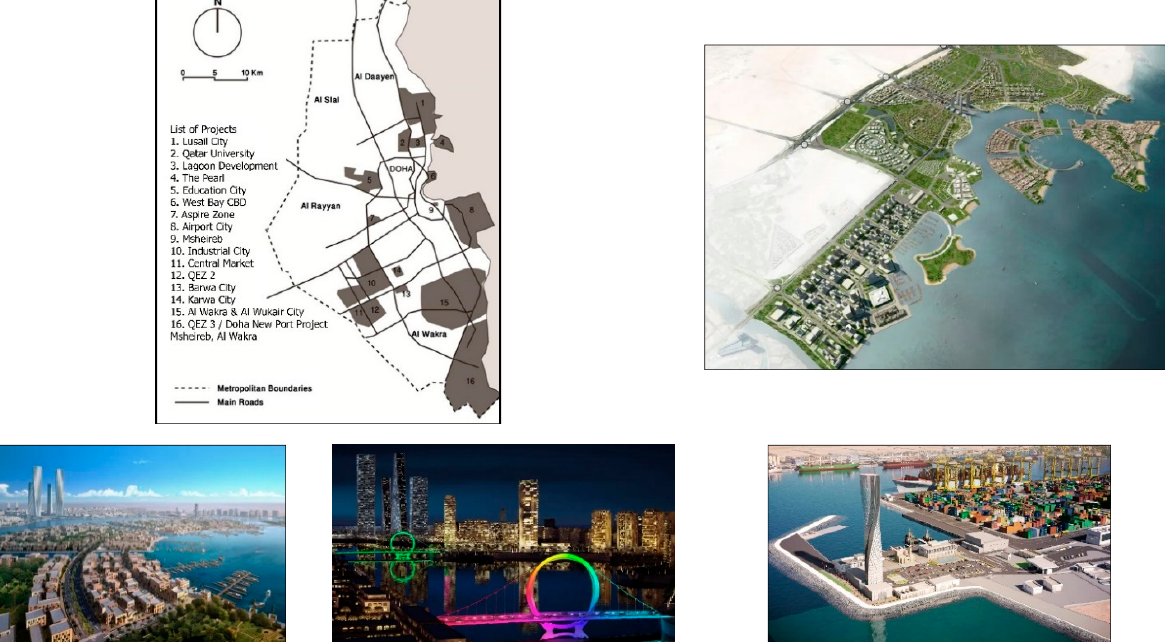
Figure 4. Doha expansion projects, including ( upper left ) a map of major projects in the city (Source: Furlan, R. Adapted from [31]), three photos of Lusail City (Source: Manfred, T. Adapted from [32]), and ( lower right ) Doha’s port (Source: Ruskin Titus Gulf. Adapted from [33]).